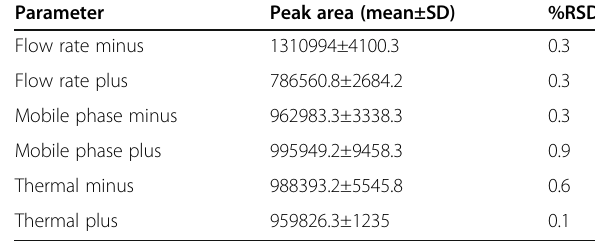
Table 7 Robustness of sitagliptin ( n